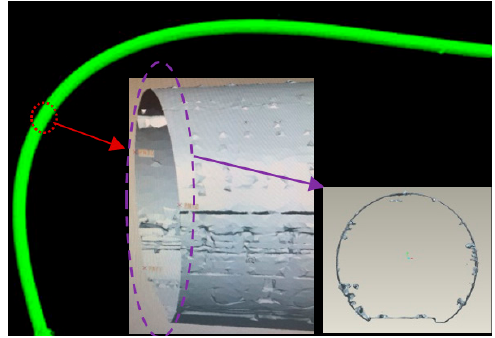
Figure 2. Disturbing objects observed from the 3D model generated by the mesh method.